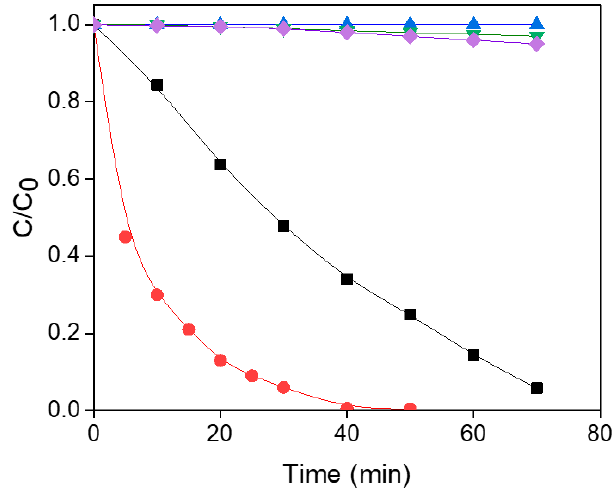
Figure 6. Loss of QY (20 ppm) in the absence of Ag 3 PO 4 under visible light ( ▲ ) or UVA ( ), in the presence of Ag 3 PO 4 in the dark ( ▼ ), upon UVA irradiation ( ) or upon visible light ( ). ([QY] 0 = 20 ppm, Ag 3 PO 4 dose = 0.5 g·L − 1 and pH~7).